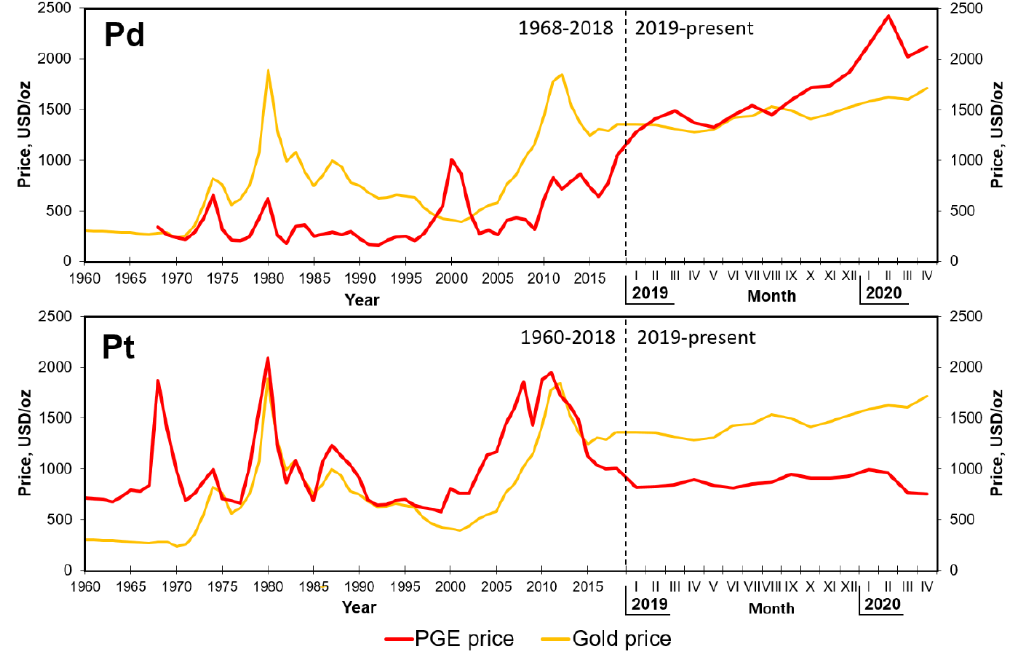
Figure 5. Historical and current price trends for Pd and Pt versus the gold price (up to April 15, 2020; inflation-adjusted prices indicated) [74,75].